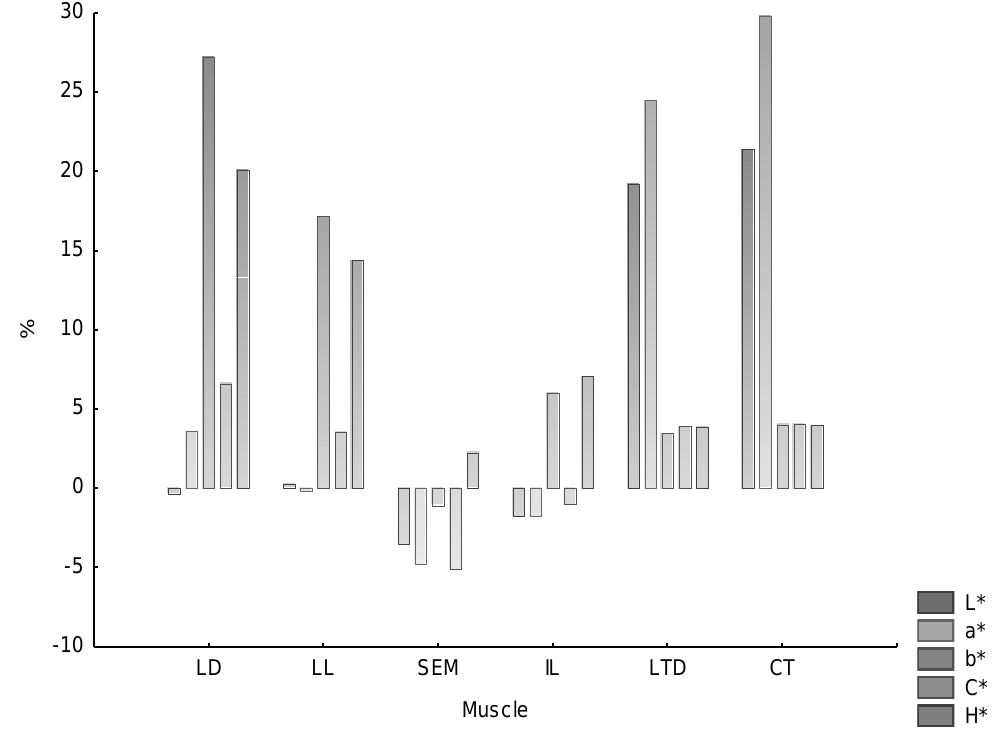
Figure 2. The percentage increase/decrease of color parameters during bloom time depending on the muscle type. LD— Longissimus dorsi , LL— Longissimus lumborum , IL— Iliacus , SEM— Semimembranosus , CT— Cutaneous trunci , LTD— Latissimus dorsi .